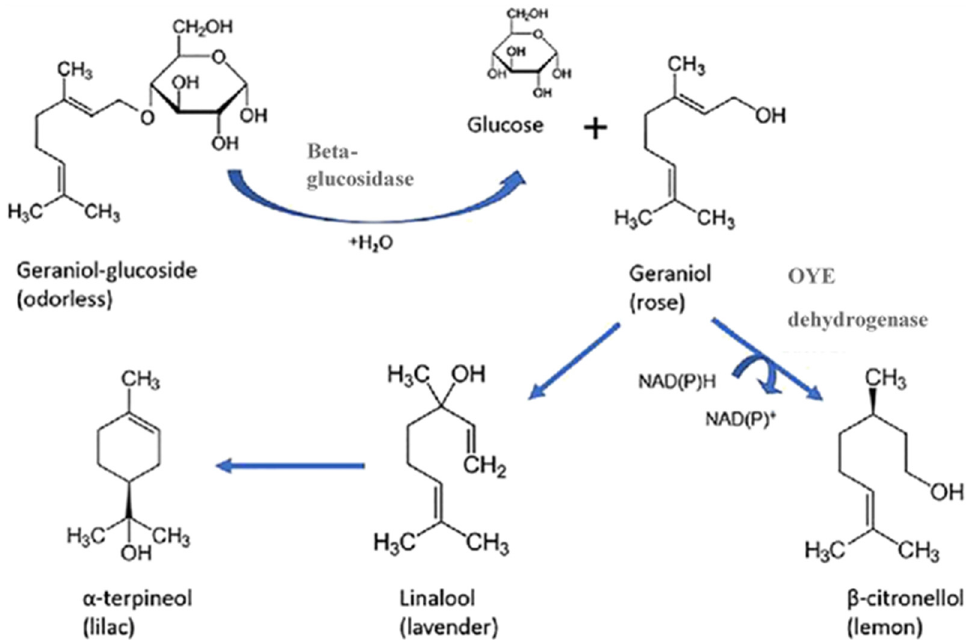
Figure 2. Beta-glucosidase activity on glucosides and bioconversion of monoterpene alcohols by yeast. Flavour descriptors adapted from the literature; modi fi ed from [19].